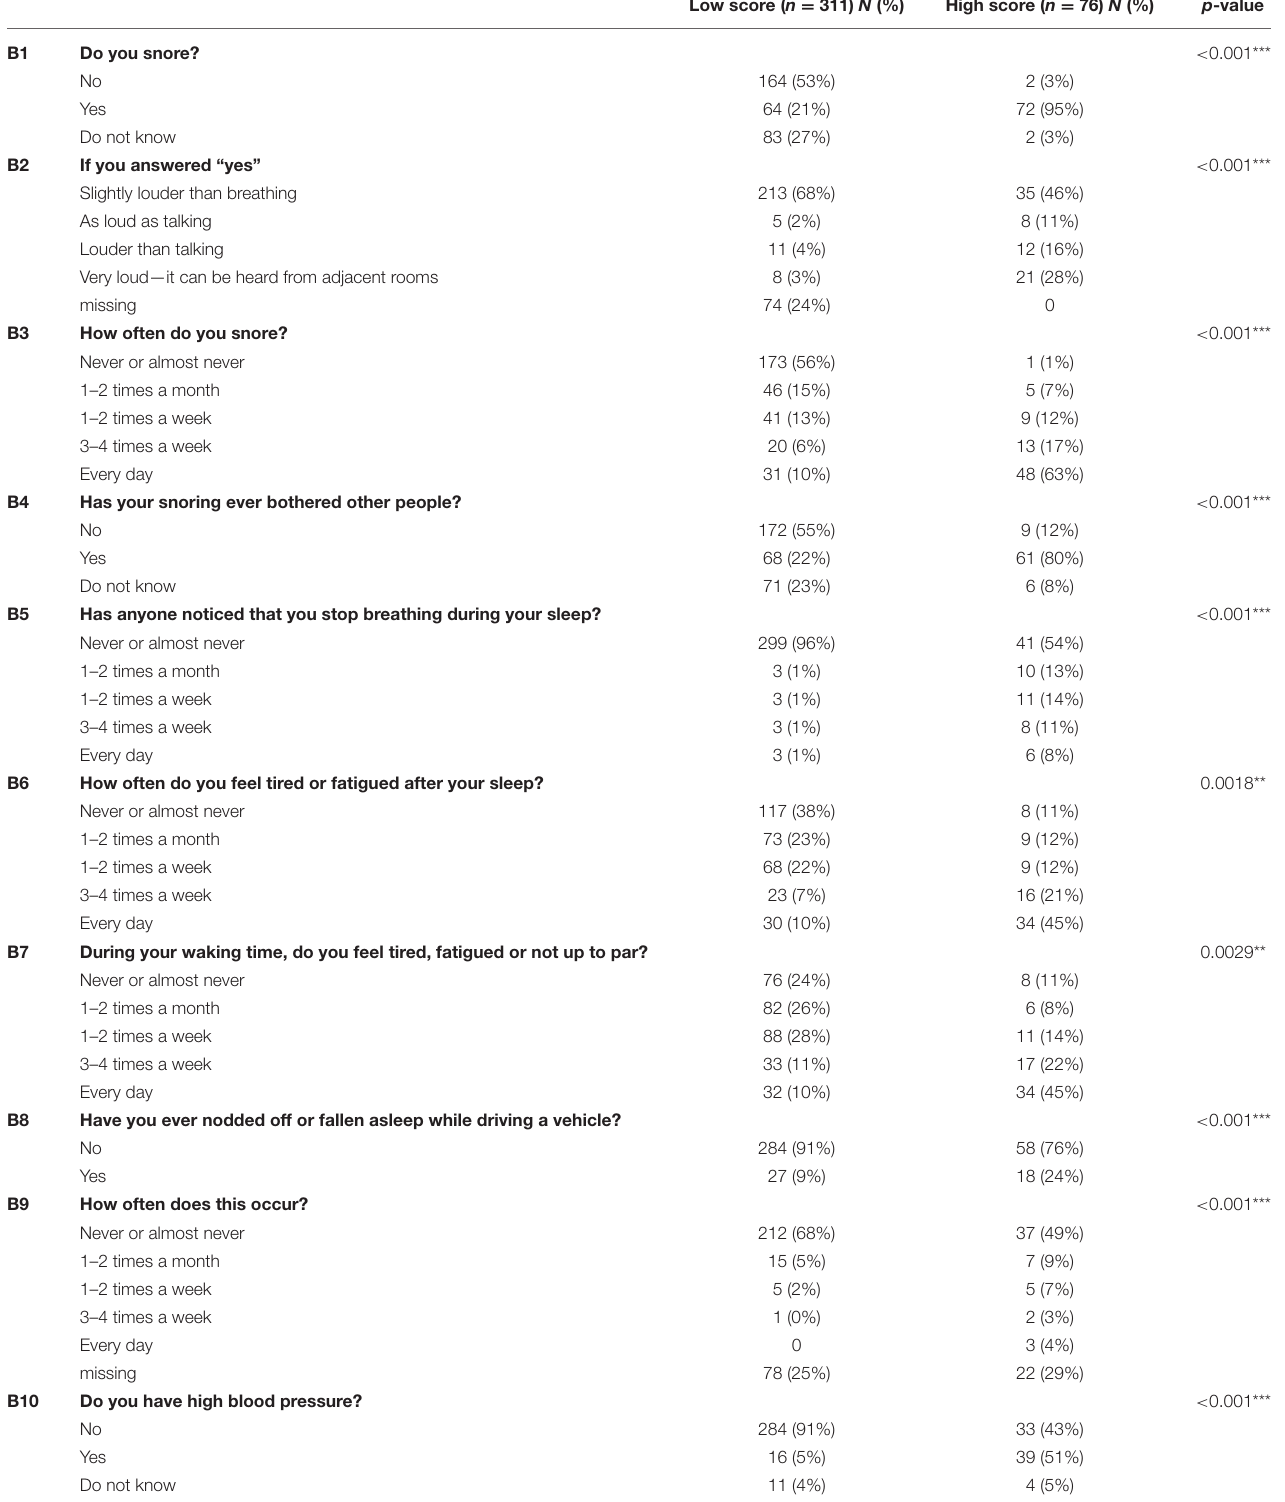
TABLE 2 | Berlin questionnaire items between low and high Berlin score (low vs. high OSA risk